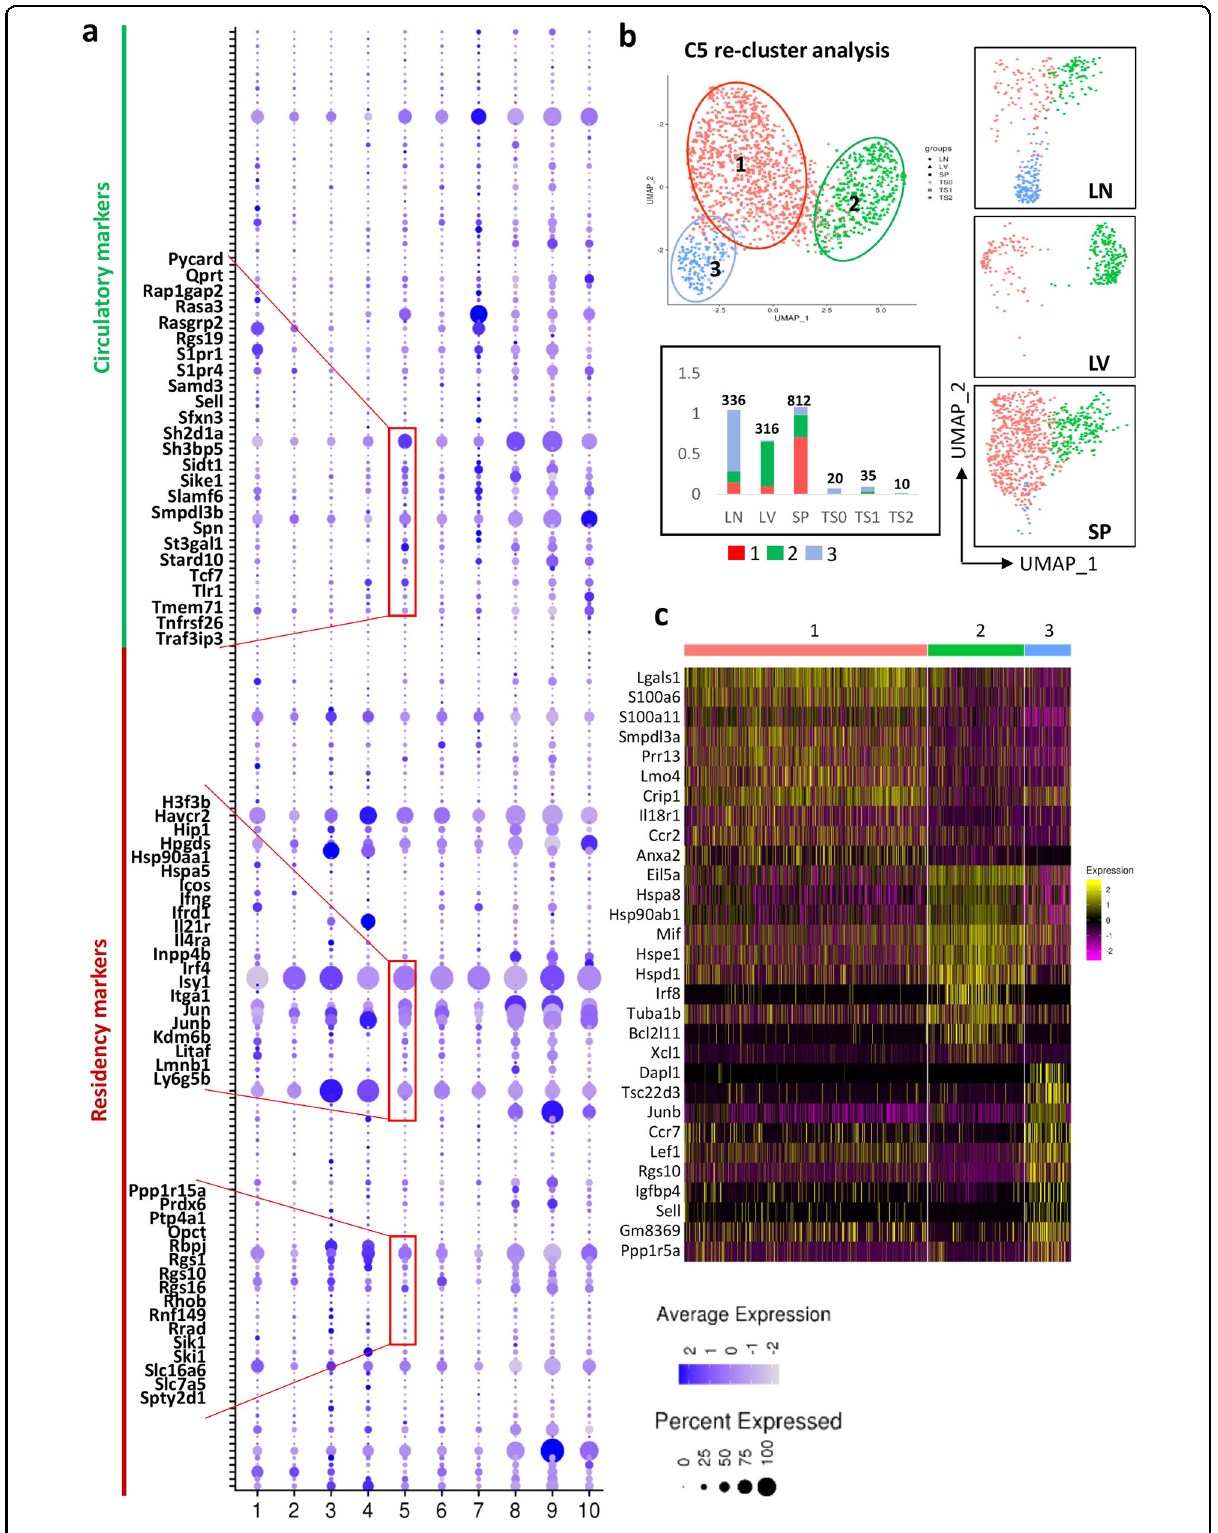
Fig. 5 RTEs characters in peripheral i NKT cells. a Dot plots showing circulatory signatures and residency signature expression in the 10 clusters identi fi ed in peripheral i NKT cells. b UMAP plots showing re-cluster analysis of C5_RTEs from Fig. 1d (top). Bar graph showing the fraction of individual clusters occupied in i NKT cells from peripheral and thymus (Stage 0, 1, 2). c Heatmap of the top ten differentially regulated genes from each cluster derived from b . Each column represents gene expression for an individual cell with color coded on gene expression pro fi les. Yellow is upregulated and purple is